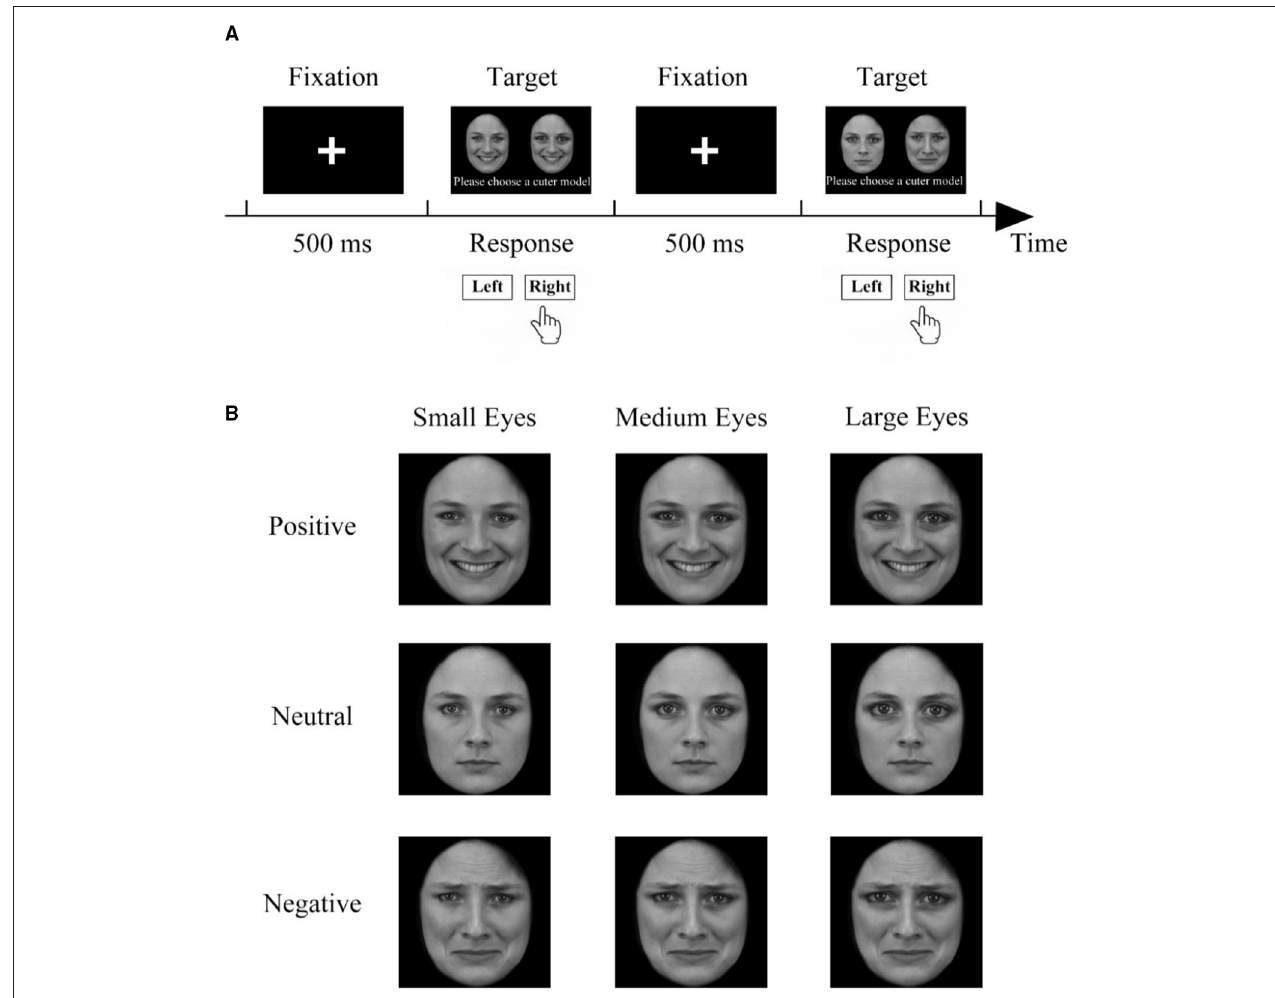
FIGURE 2 | The paired-comparisons procedure. (A) The experimental process of a pair of comparative methods. First, the fixation point was displayed for 500ms in the center of the screen, and then two stimuli of the same model with different features appeared at the same time. The participants were asked to choose the one they considered cuter. After the participant made a choice, a new set of fixed points was presented. (B) Example photos of the same model for pairwise comparison of 9 stimuli from the same model (no stimulus is compared with